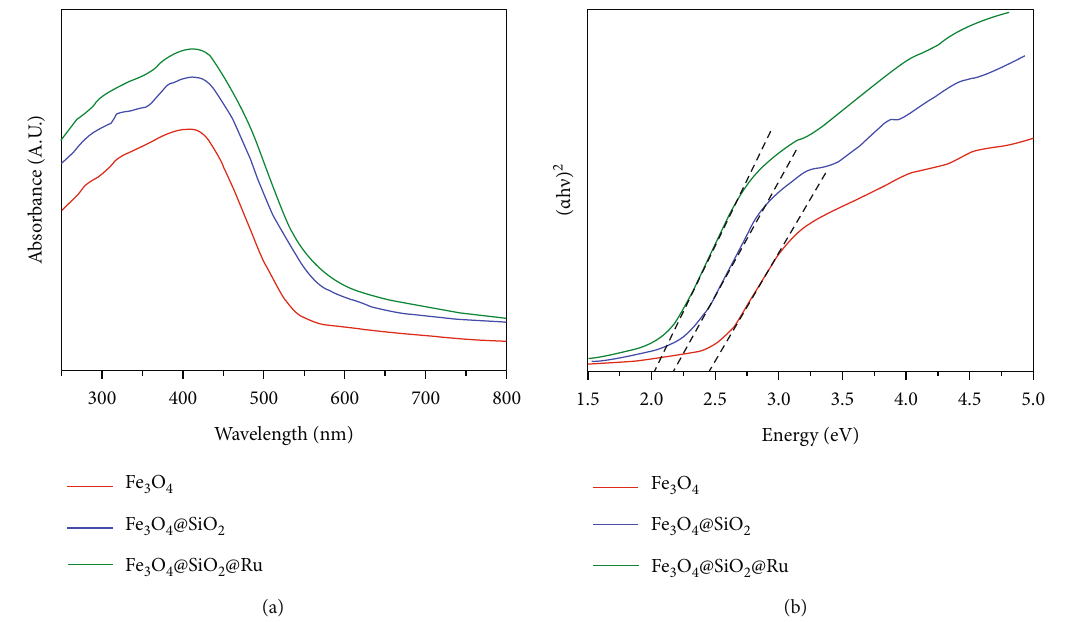
Figure 7: (a) UV-Vis DRS and (b) Tauc plots of Fe